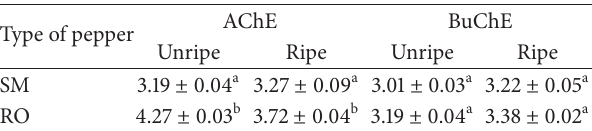
Table 3: EC values for inhibition of acetylcholinesterase and 50 butyrylcholinesterase in